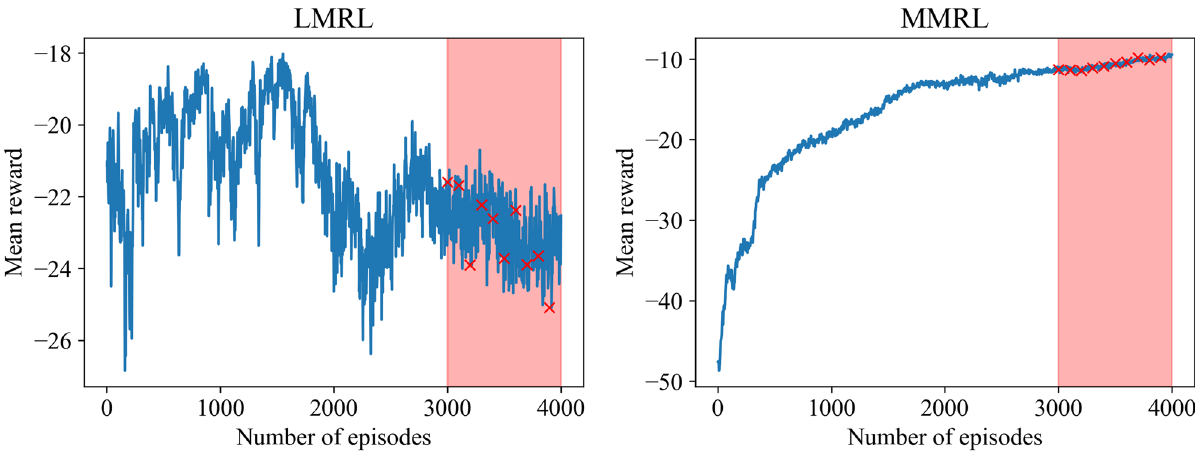
Figure 5. Evolution of the moving average mean reward for LMRL (left) and MMRL (right) approaches. The models used for testing are indicated by red